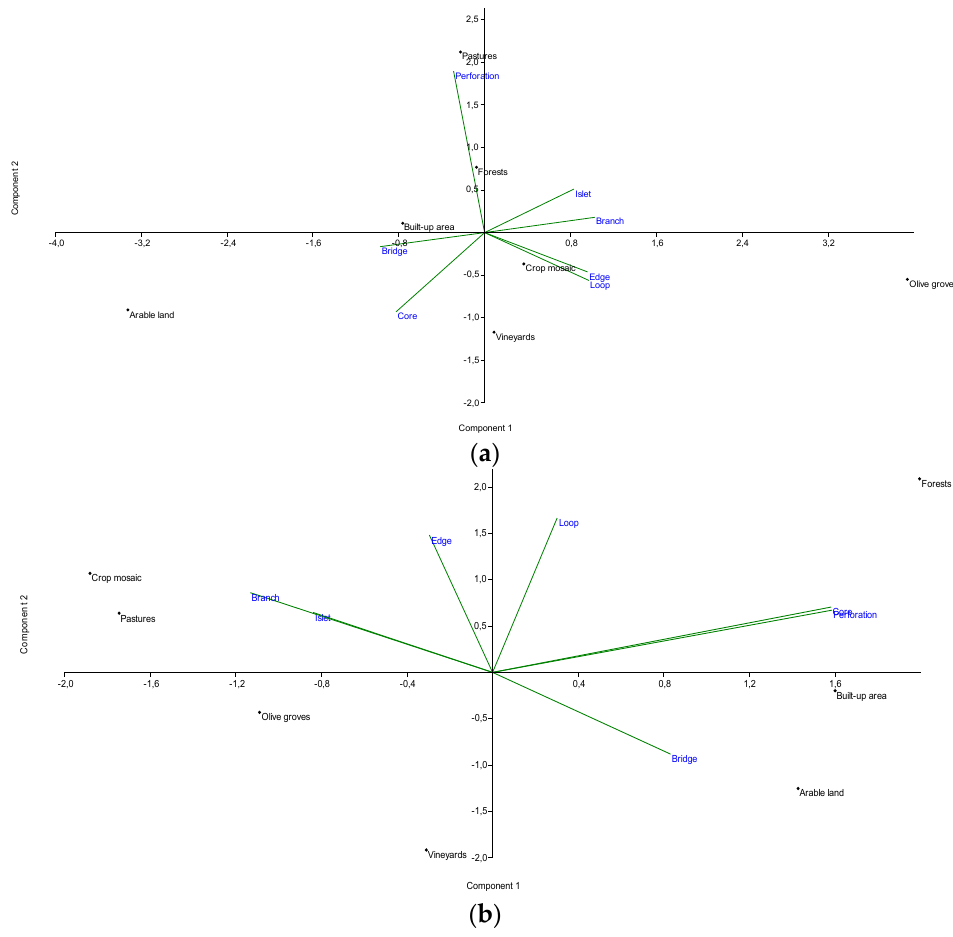
Figure 5. Biplot of a Principal Component Analysis investigated similarities and differences in the spatial distribution of the average patch size (ha) by land-use class and morphological category; ( a ) 1949, ( b )